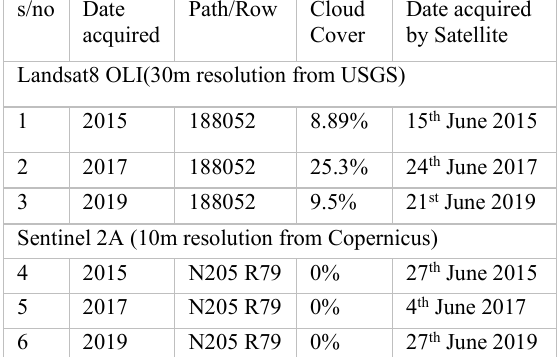
Table 2: Classification